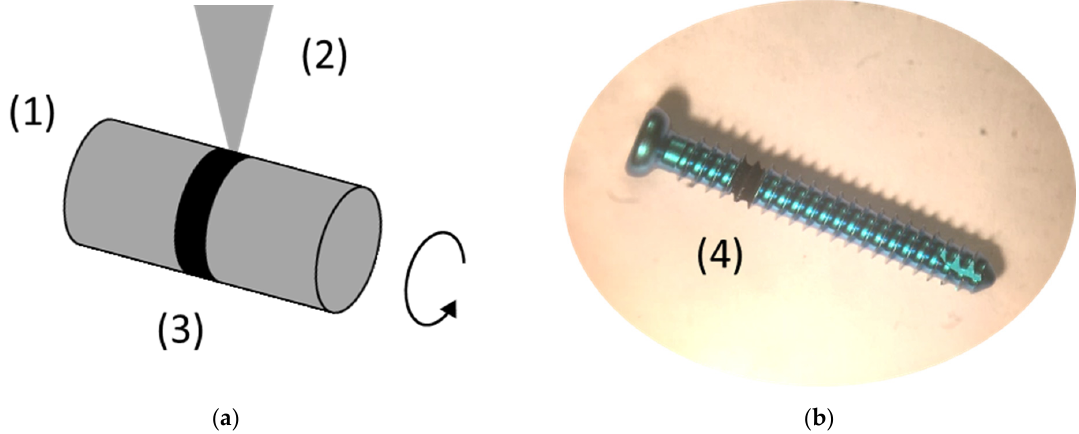
Figure 1. ( a ) Schematics of the laser-structuring of a cylindrical sample. The sample (1) was rotated around its the symmetry axis during the surface-processing with a focused femtosecond laser beam. The laser beam is shown schematically as a triangle (2), the processed surface in black (3). ( b ) Bone screw with a dark femtosecond laser-processed ring (4).